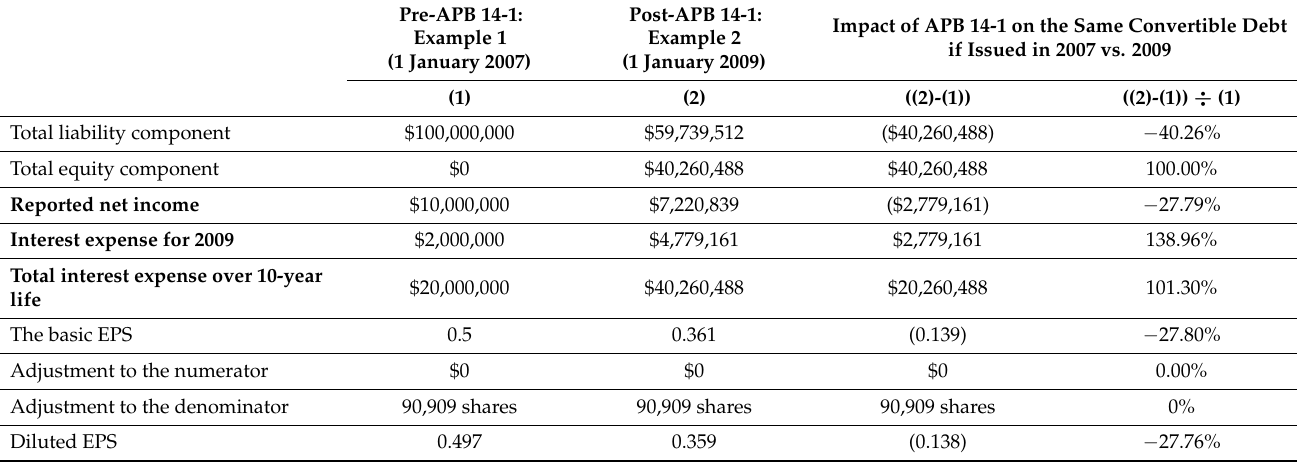
Table A1. Summary of impact of APB